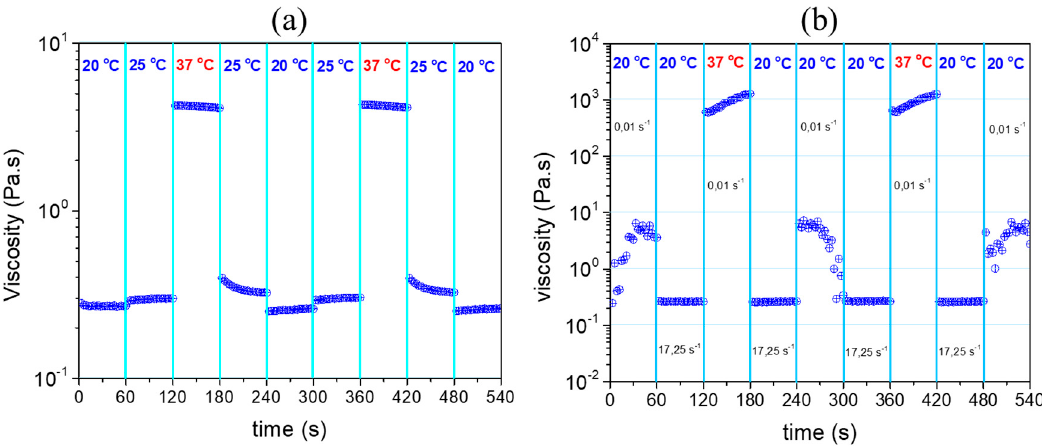
Figure 7. Shear viscosity stepwise time sweep in time intervals of 60 s: ( a ) altering temperatures at constant shear rate of 17.25 s − 1 and ( b ) altering simultaneously temperature and shear rate as indicated for the ALG/HGC formulation.